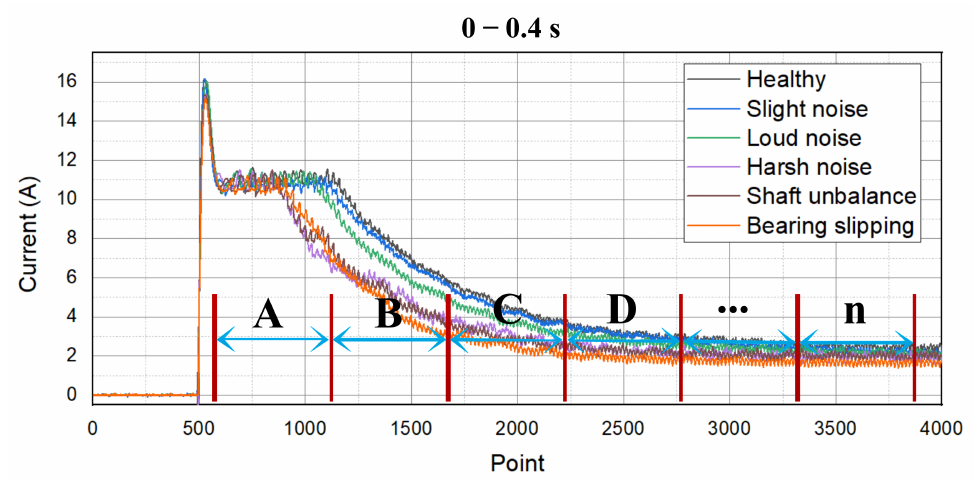
Figure 6. Multi-segment feature extraction. (A, B, C, D, · · · , n represent the multi-segment